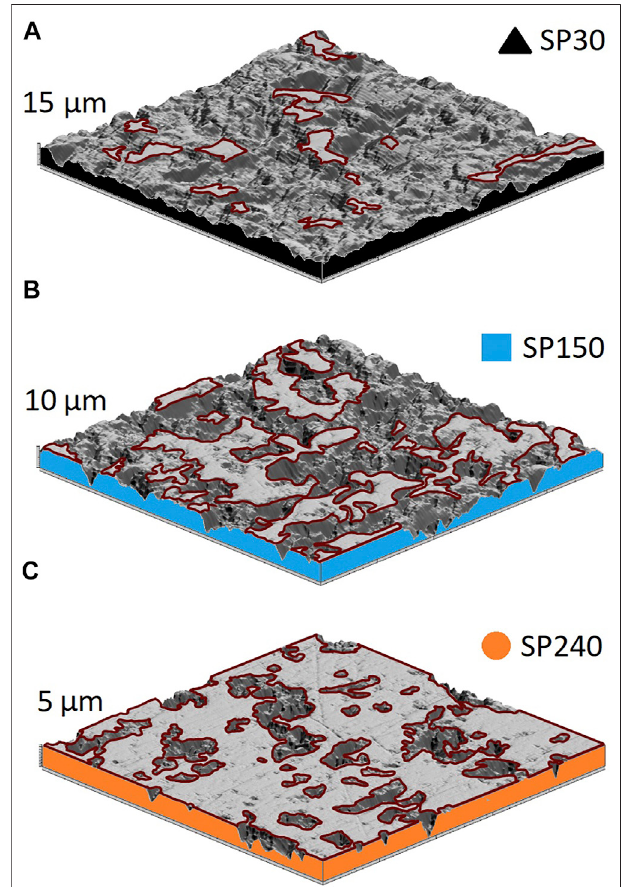
FIGURE 3 | Closeup (500 μ m × 500 µm) of sample surface 3D photo simulation obtained with contact type pro fi lometer: (A) sample SP30 was polished for 30 s; (B) sample SP150 was polished for 150 s; (C) sample SP240 was polished for 240 s. Polishing reduces the total asperity height and increases the percentage of the smooth areas on top of the surface. The contour of the polished area is marked with a red outline. This smooth area of the texture will be the fi rst to interact with the opposing ice surface. A larger and smoother surface area reduces contact pressure between the sample and ice. Lower contact pressure reduces sample penetration in soft ice, thus improving surface ability to slide at higher air temperatures, but at very low temperatures larger contact area might have a negative in fl uence, i.e., a smooth surface might freeze together with ice thus slowing or even stopping the